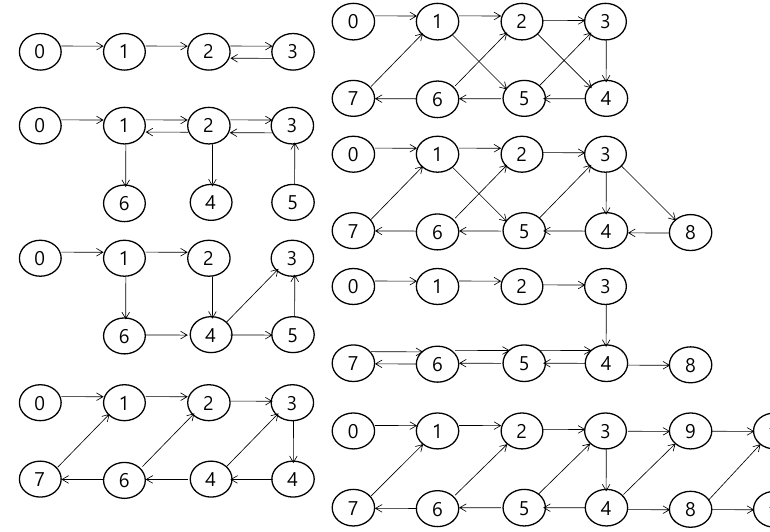
Figure 2. Communication graphs used for train data generation.